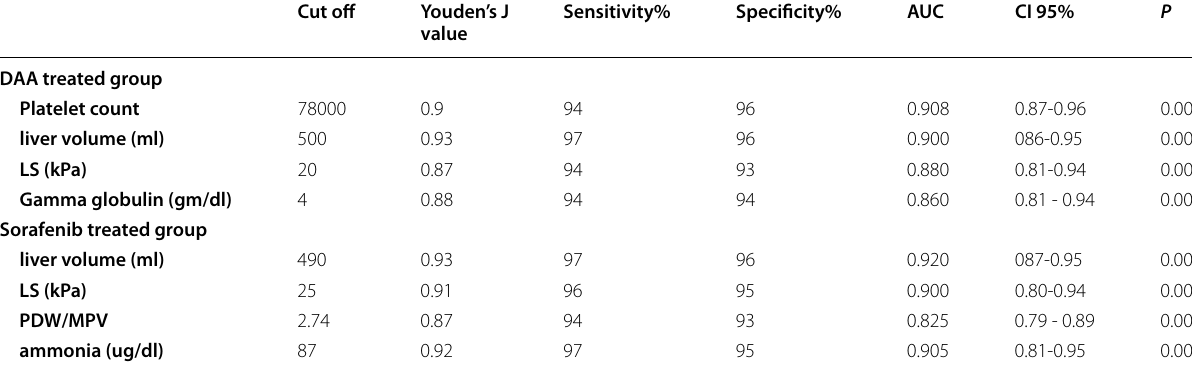
Table 5 Cut-off values (by ROC curve) of the high risk variables independently associated with complications and adverse outcome in both treated